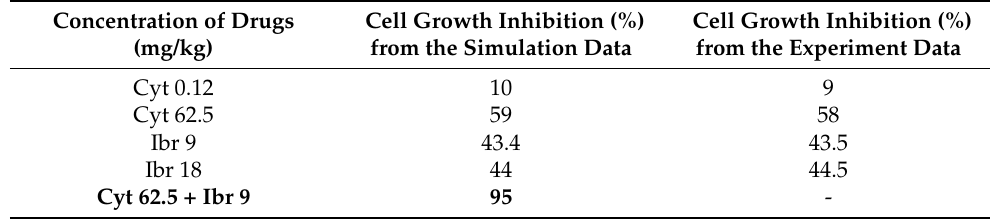
Table 2. Results of Experiments and